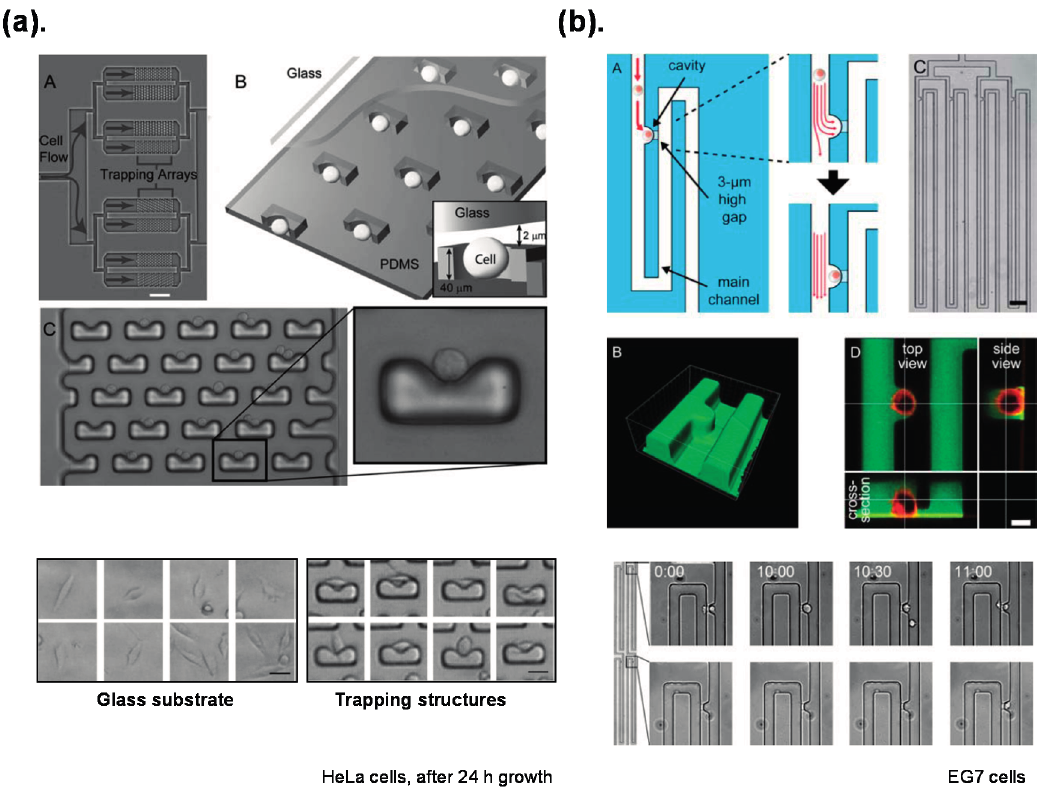
Figure 2. Individual cell isolated on a chip with microfluidic hydrodynamic traps described in: ( a ) Di Carlo et al. , 2006 [26]: ( A ) A photograph of the cell trapping device; ( B ) A diagram of the device and mechanism of trapping; ( C ) A high resolution micrograph of the trapping device; ( b ) Kobel et al. , 2010 [60]: ( A ) Schematic illustration of the single cell trap; ( B ) A three-dimensional reconstruction image of the cell trap; ( C ) An array of the single cell traps; ( D ) An orthogonal view of a fluorescently labeled single cell.